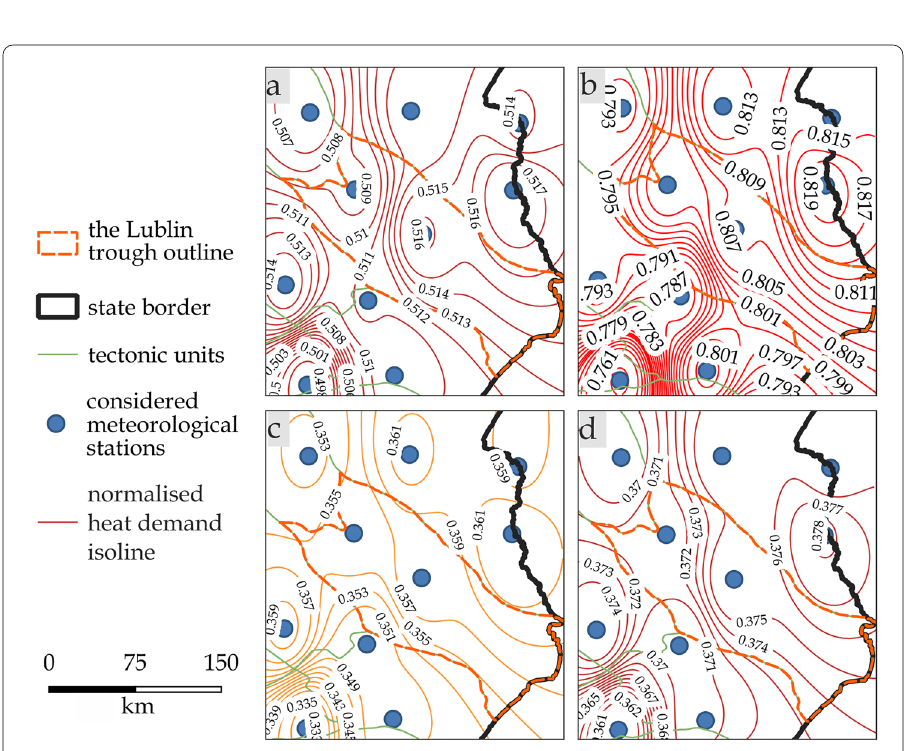
Fig. 9 Maps presenting expectable statistical values of normalised heat demand in the Lublin trough: a 75th percentile median; b 99th percentile; c median; d mean. Blue dots indicate location of meteorological stations with long enough logs of required